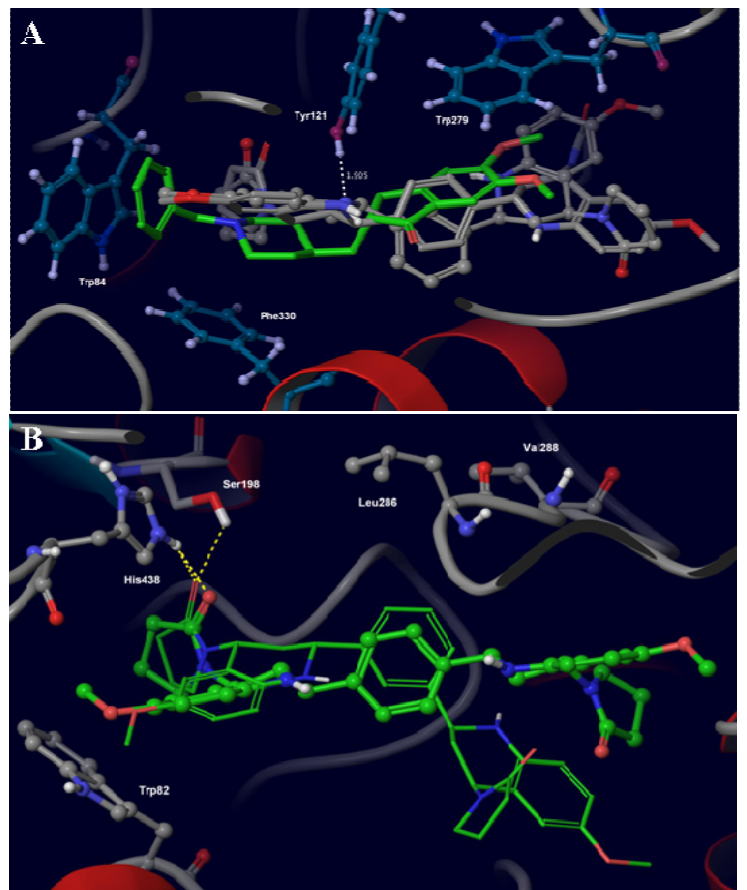
Figure 1. ( A ) Main molecular interactions established by compounds E2020 (green carbon atoms), 5c (gray carbon atoms and ball-stick representation) and 4c (gray carbon atoms and stick representation) within AChE binding site. ( B ) Main molecular interactions established by compounds 5c (green carbon atoms and thin stick representation) and 4c (green carbon atoms and width stick representation) within BuChE binding site. Only main amino acids within AChE and BuChE are sketched for the sake of